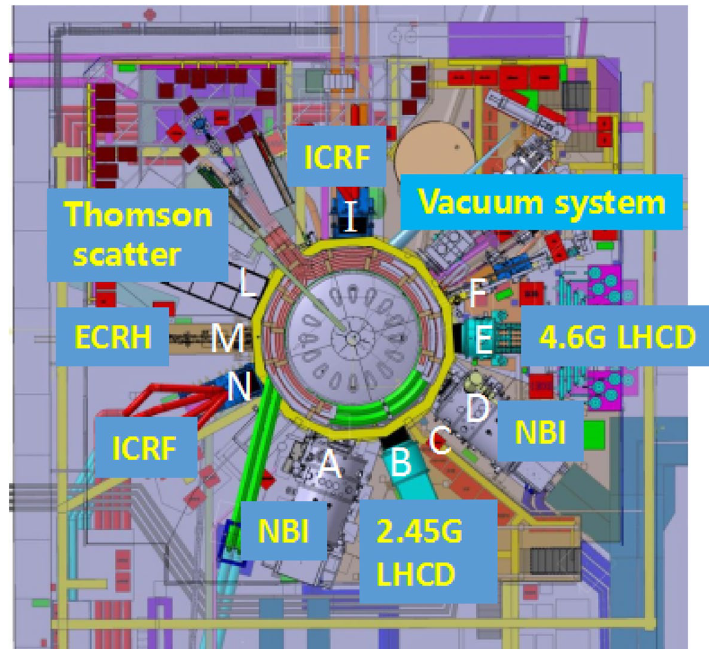
Fig. 4 Distribution of EAST main